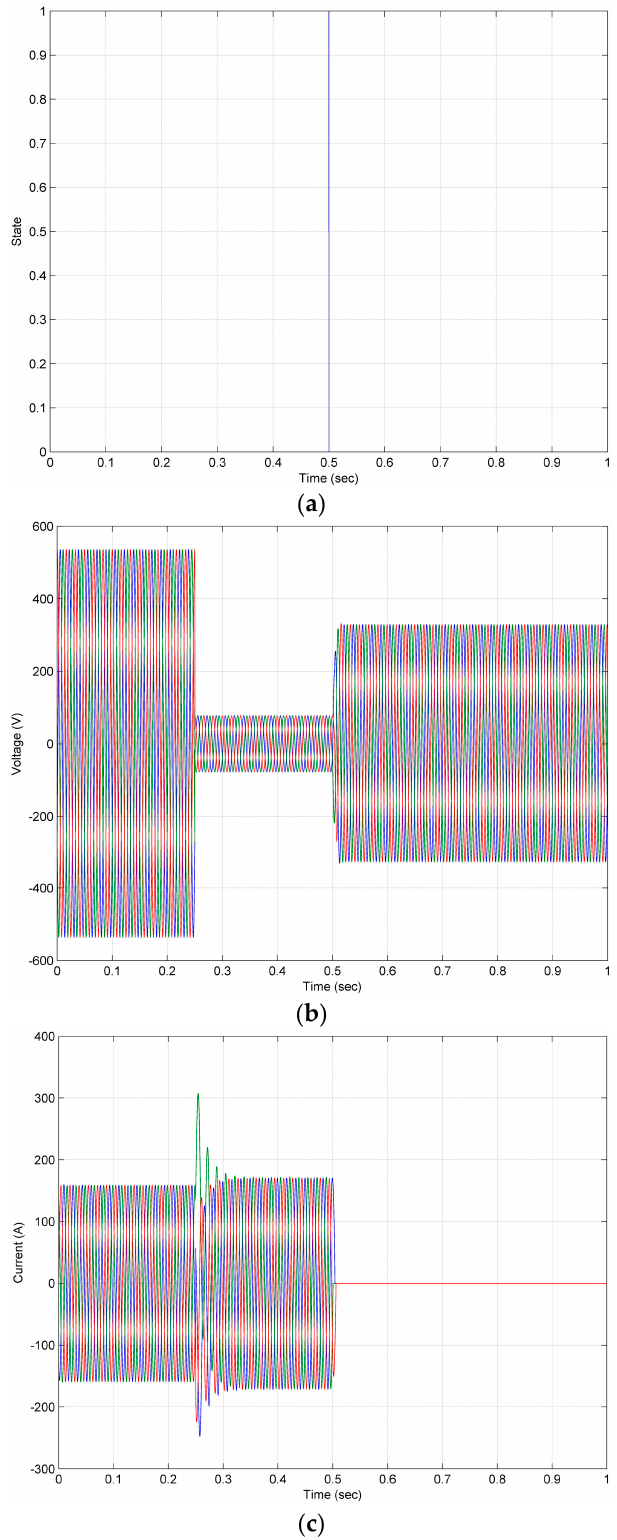
Figure 8. ( a ) CB10 CLOSE/TRIP state; ( b ) Feeder voltage waveforms of CB 10 under grid-connected mode and fault occurrence at Bus 1; ( c ) Feeder current waveforms of CB 10 under grid-connected mode and fault occurrence at Bus 1.